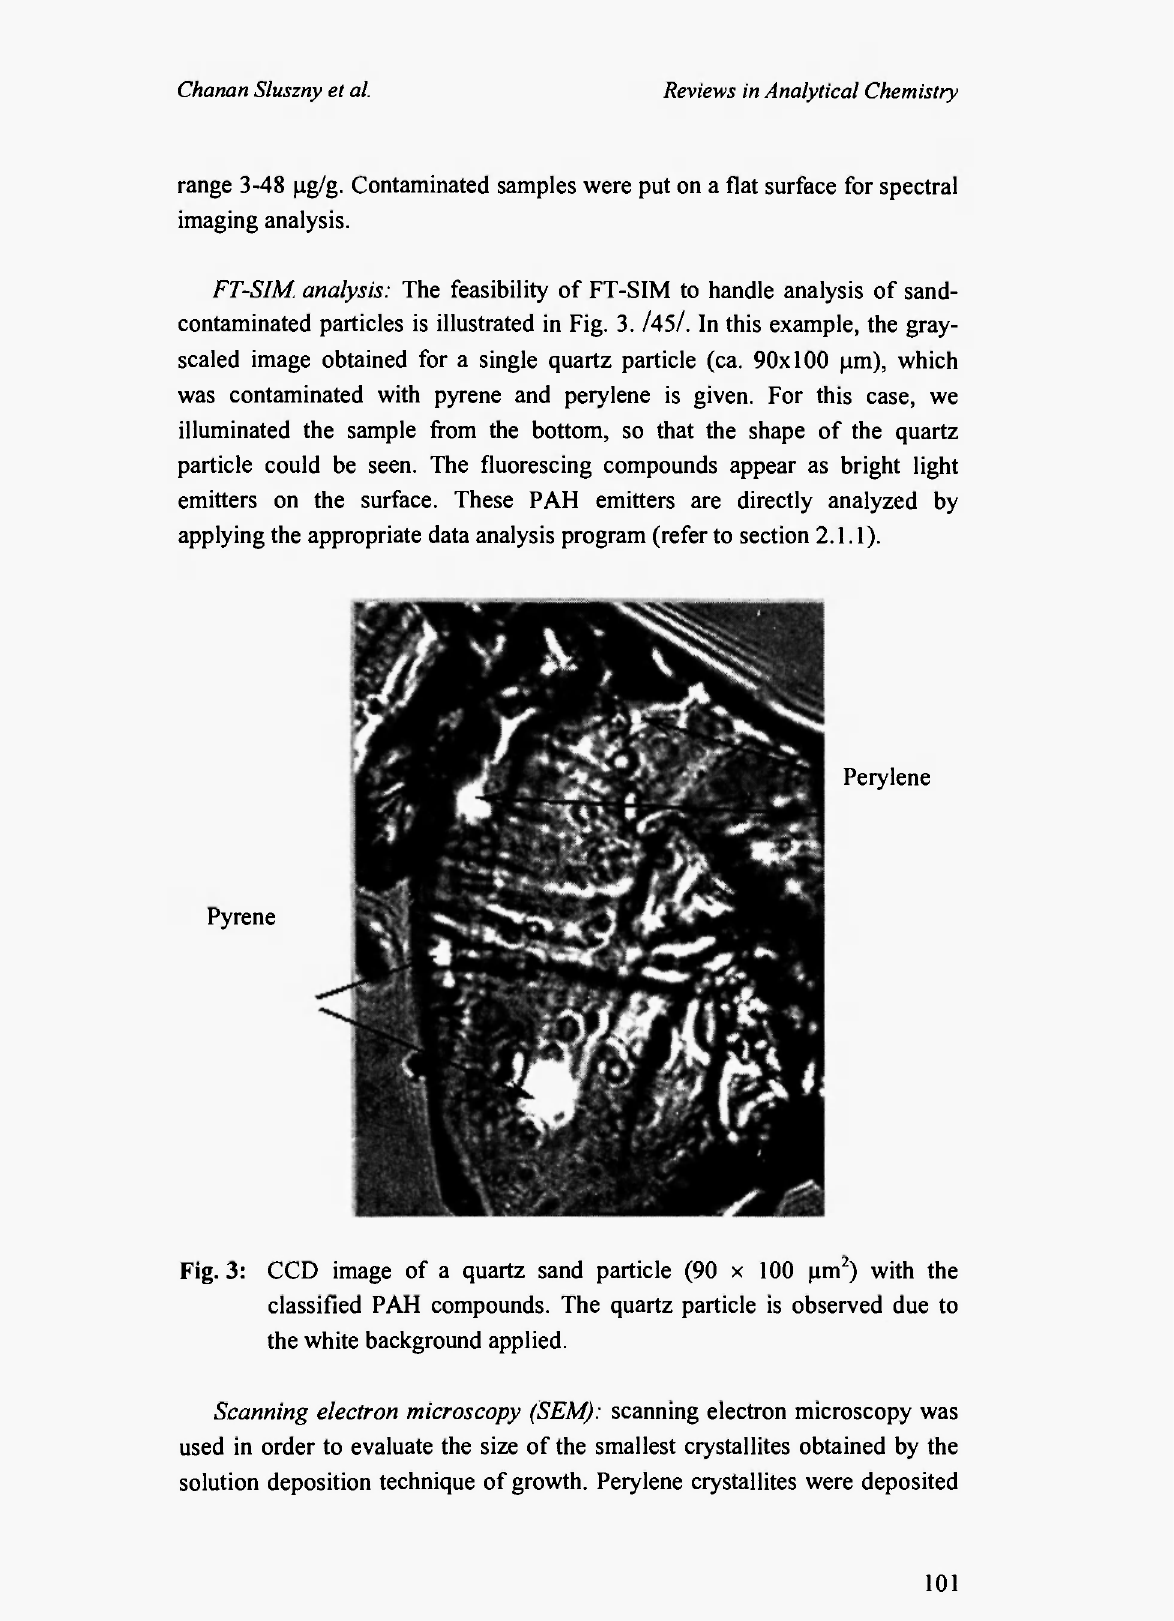
Fig. 3: CCD image of a quartz sand particle (90 χ 100 μηι 2 ) with the classified PAH compounds. The quartz particle is observed due to the white background